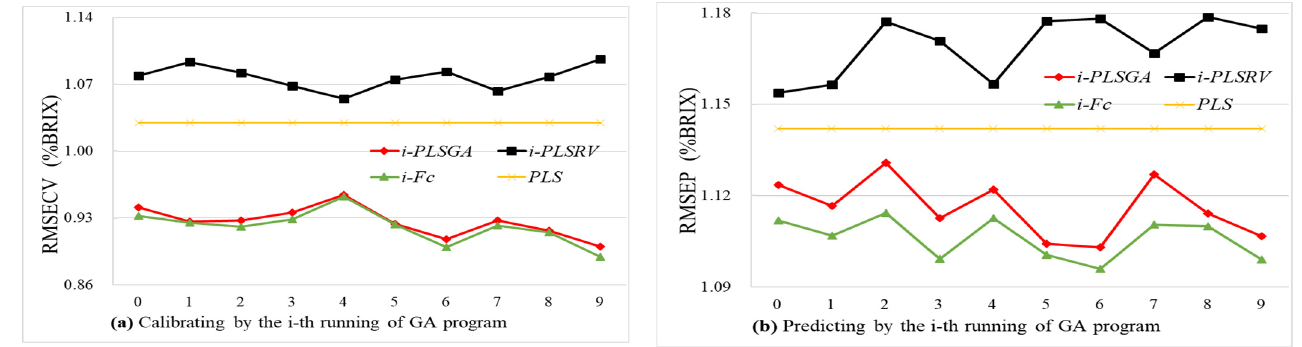
Figure 4. Root mean square error of models with the selected variables by GA, residual variables, and consensus fusion ( a ) Calibration set ( b ) Prediction set.